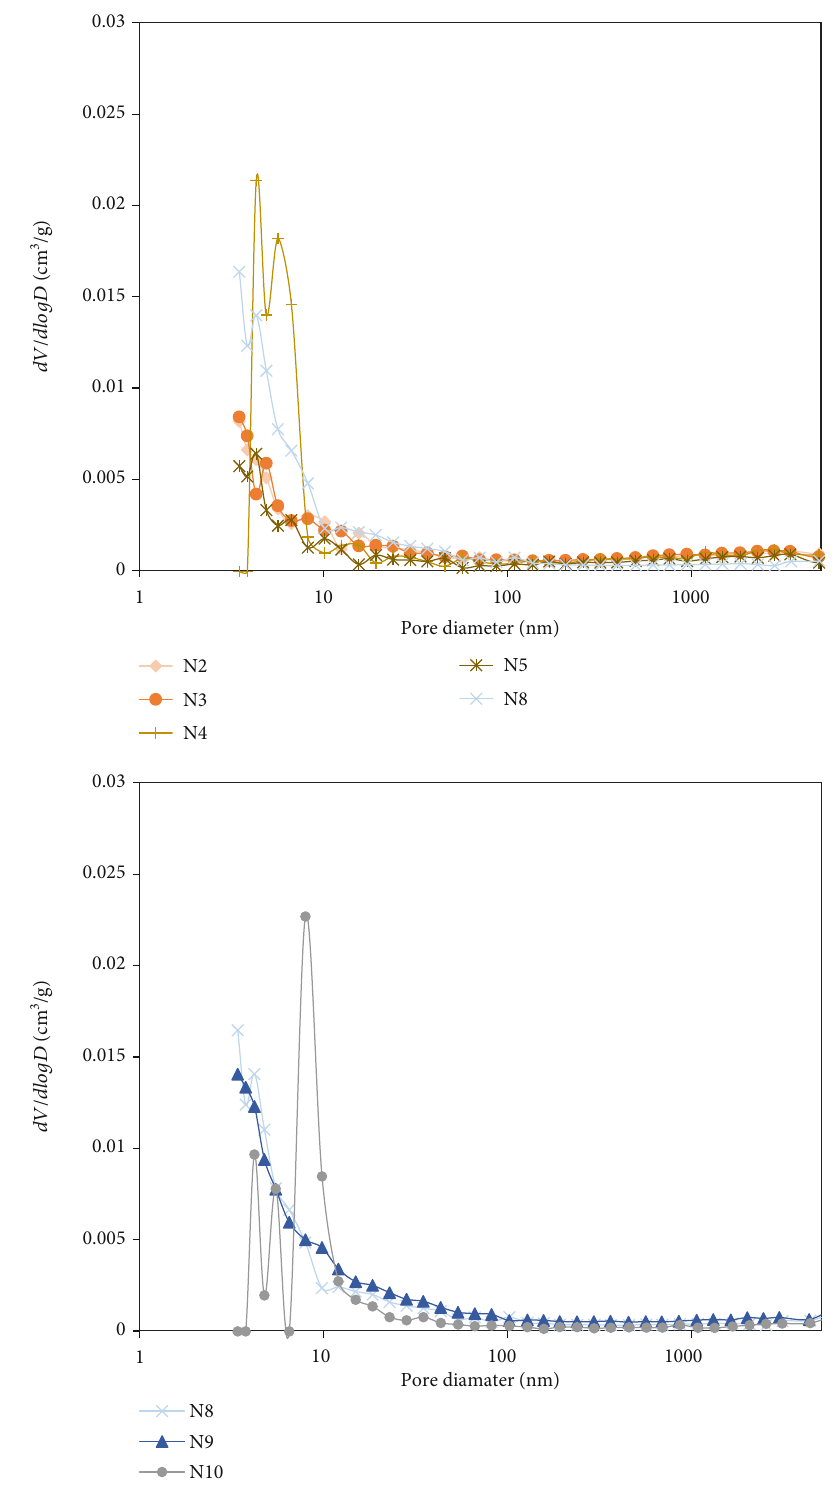
Figure 16: Log di ff erential pore volume for Wufeng-Longmaxi shales derived from MICP. The x -axis marked the pore diameter in the nanometer, and the y -axis marked the log di ff erential pore volume. Samples N8, N9, and N10 featured higher TOC contents than samples N2 to N8. The TOC contents of N8 to N10 are 2.98%, 3.39%, and 3.52%,